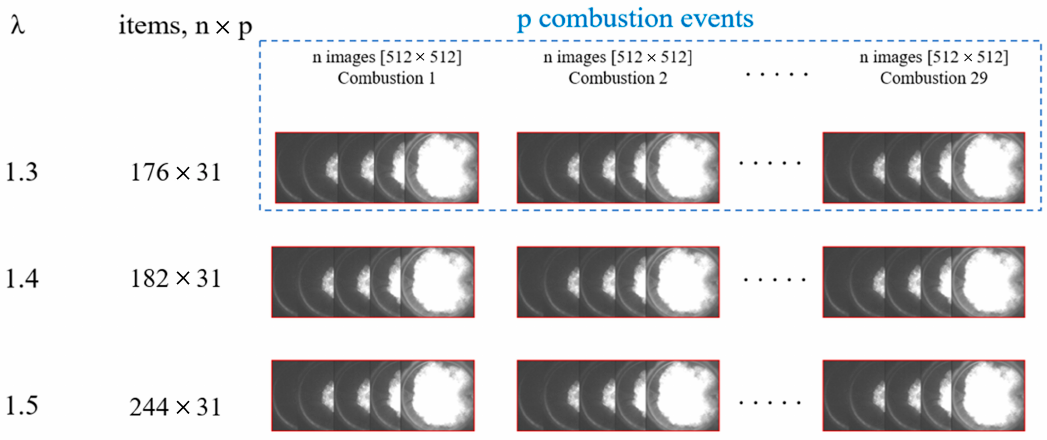
Figure 5. Number of items used for the training session at each lambda value analyzed.